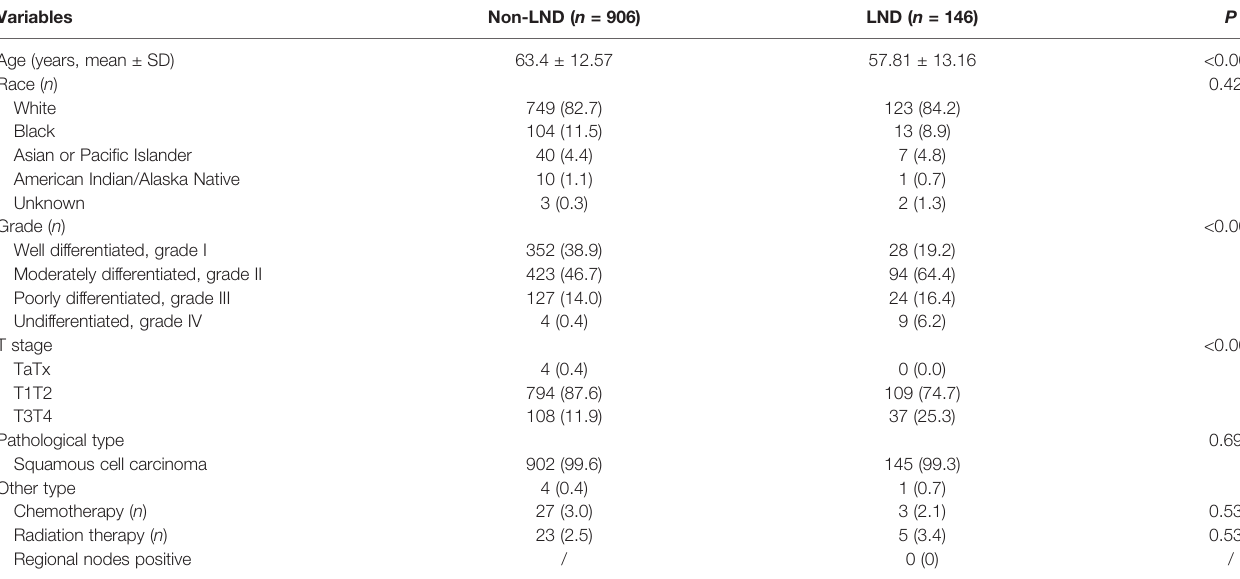
TABLE 1 | Baseline characteristics of included patients.